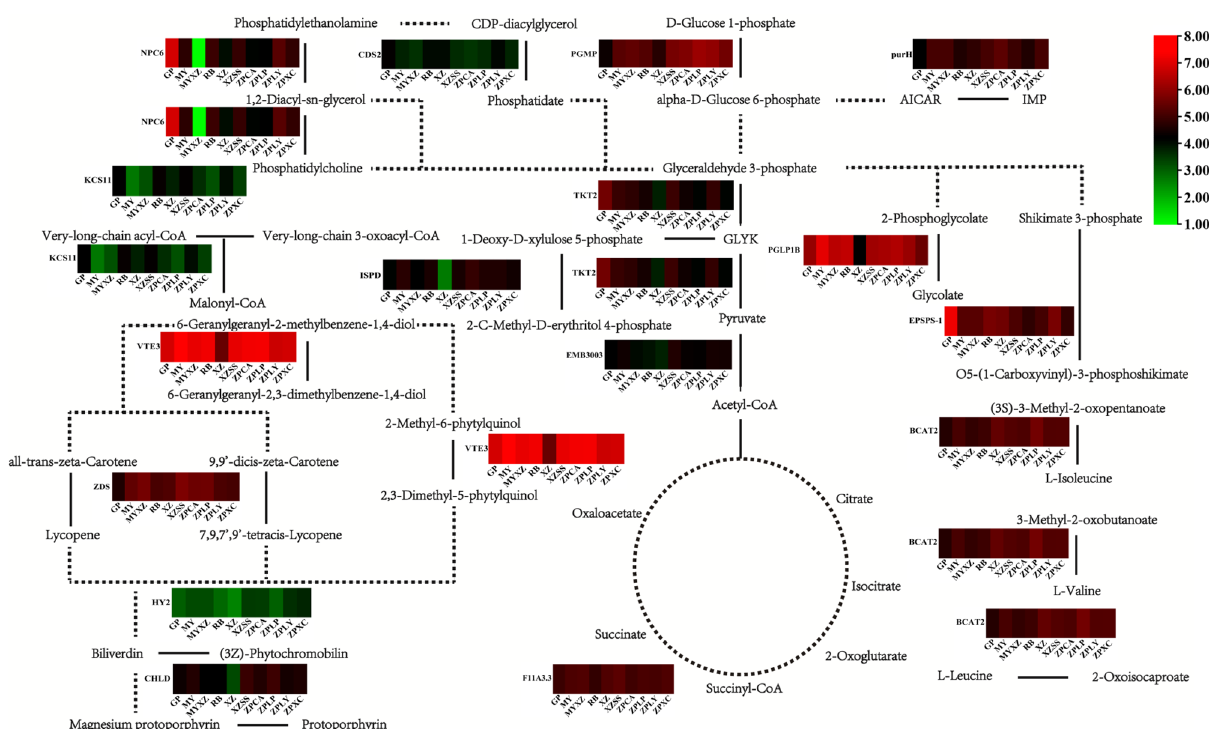
Figure 8. Gene expression models in biosynthesis of secondary metabolites pathway. This graph displays part of the biosynthesis of secondary metabolites. Dotted lines describe indirect metabolism flow; solid lines describe direct metabolism flow. The coloured bar describes the gene expression level in the corresponding position. RPKMs in heatmaps are standardized by the log 2 (RPKM) algorithm; green indicates a low expression level, and red indicates a high expression level. Metabolites pathway was drawn by Adobe Illustrator CS5 software, heatmaps were visualized by TBtools